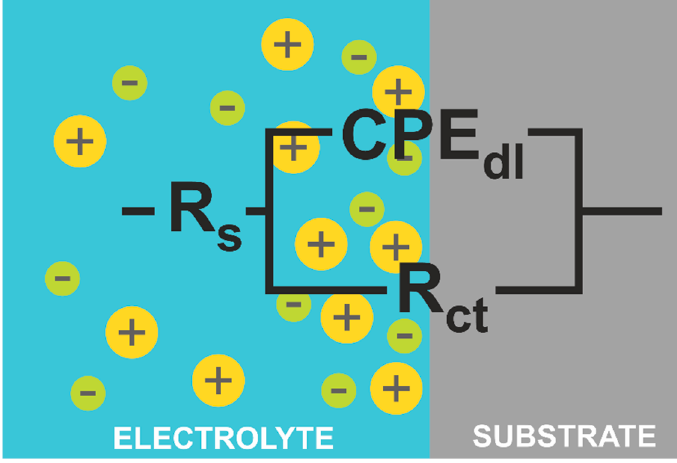
Figure 8. EIS for specimens in 0.5 M NaCl—Bode plots.